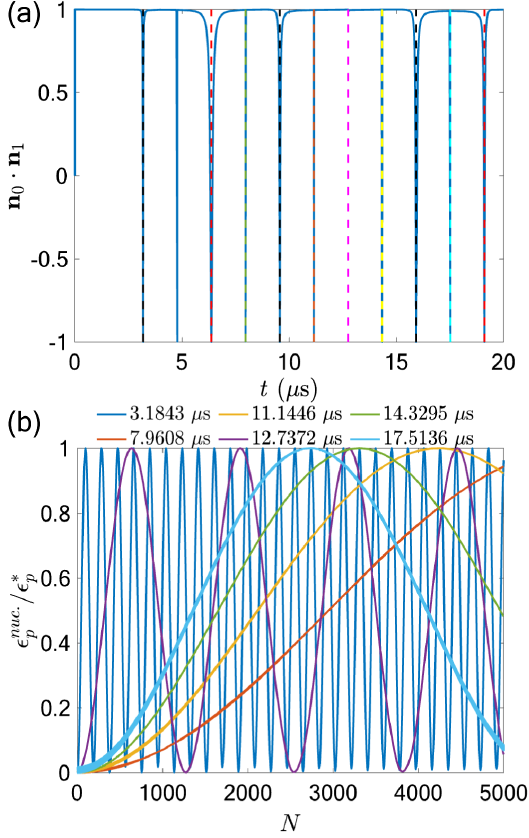
FIG. 15. (a) Dot product of nuclear axes as a function of the time of one UDD 4 sequence unit. (b) Nuclear one-tangle 2 = 9 , for various resonance times, as a function scaled by ϵ (cid:3) p ¼ of the iterations of one unit. All times besides the first one at 3 . 1843 μ s correspond to the additional times we list in Eq. (I4). For these resonance times, a very large number of iterations is required to reach the first maximum of the nuclear one-tangle. The curves which look as though they have larger linewidth are, in fact, highly oscillatory as a function of N . (i.e., spin projections s 0 ¼ − s 1 ¼ 1 = 2 ) and a nuclear spin with parameters ð A; B; ω Þ ¼ 2 π · ð 70 ; 10 ; 314 Þ kHz. The L black vertical lines correspond to the resonance times t ¼ 4 π ð 2 k − 1 Þ = ˜ ω , whereas the red vertical lines to the k times t ¼ 8 π ð 2 k − 1 Þ = ˜ ω . Additionally, the green line k corresponds to the time t ¼ 10 π ð 2 k − 1 Þ = ˜ ω , the magenta k line to t ¼ 16 π ð 2 k − 1 Þ = ˜ ω , the yellow line to t ¼ k k 18 π ð 2 k − 1 Þ = ˜ ω , and the cyan line to t ¼ 22 π ð 2 k − 1 Þ = ˜ ω . k